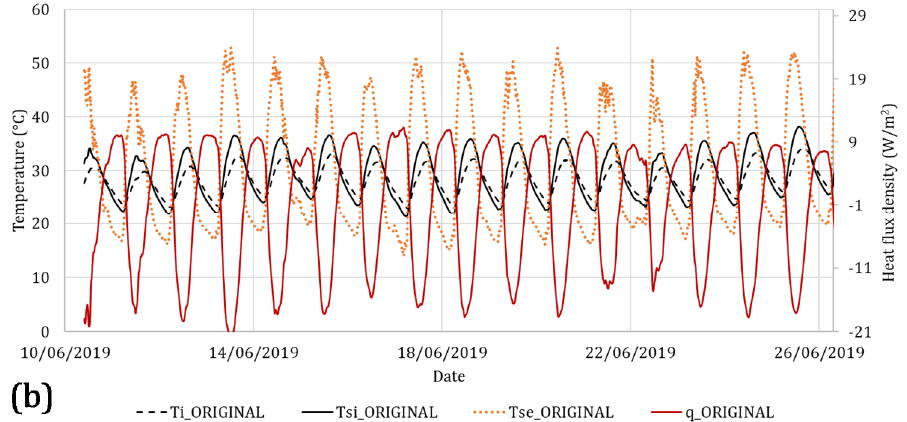
Figure 8. Heat fluxes, indoor temperatures and internal surface temperatures registered during summer for the green roof ( a ) and the original one ( b ).